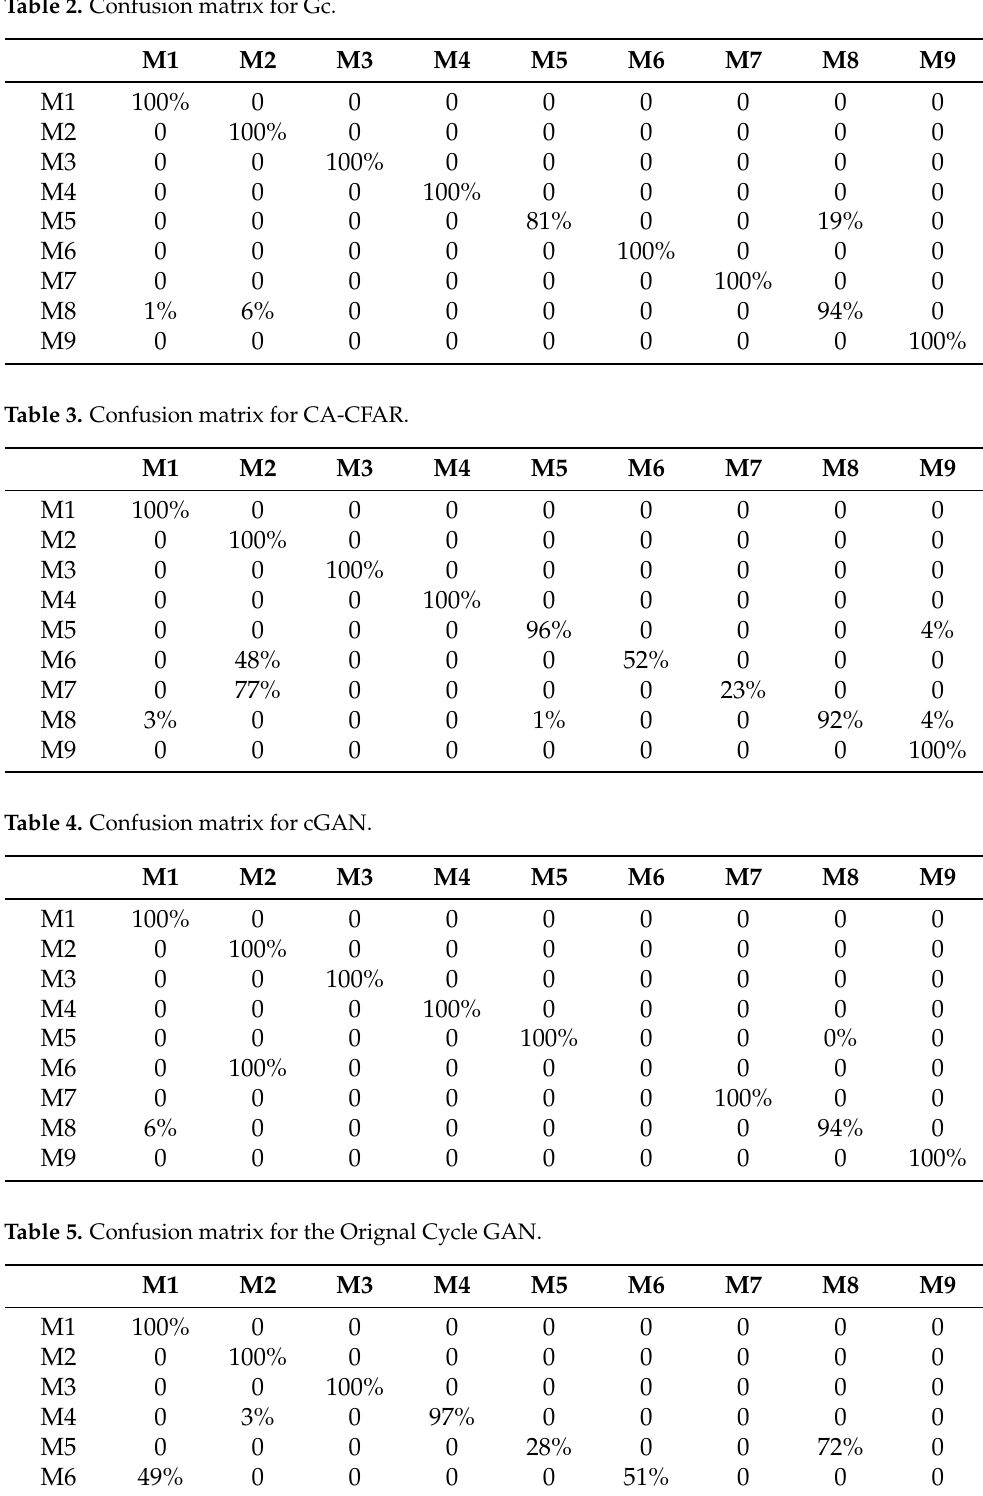
Table 2. Confusion matrix for Gc.